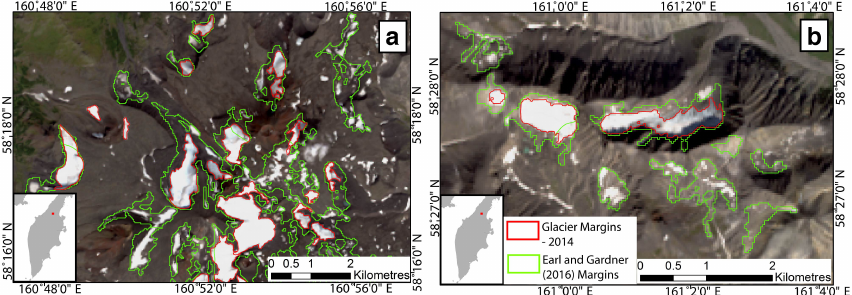
Figure 8. Comparisons, from across Kamchatka, between our mapping (based on Landsat 8 imagery captured in 2014) and the mapping of Earl and Gardner